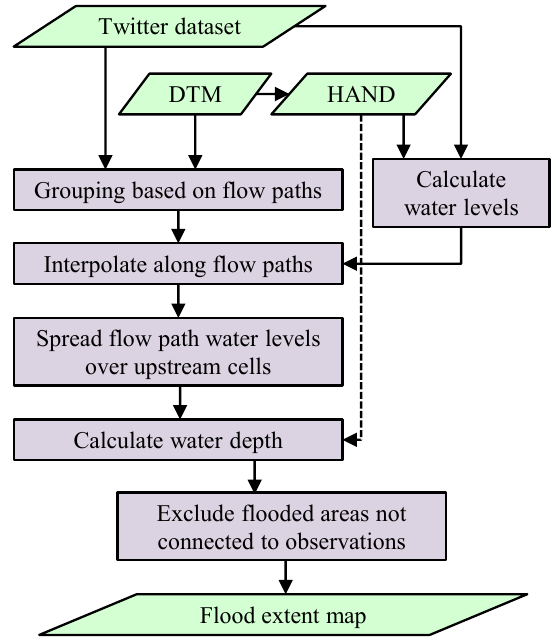
Figure 4. Process of creating flood extent maps.